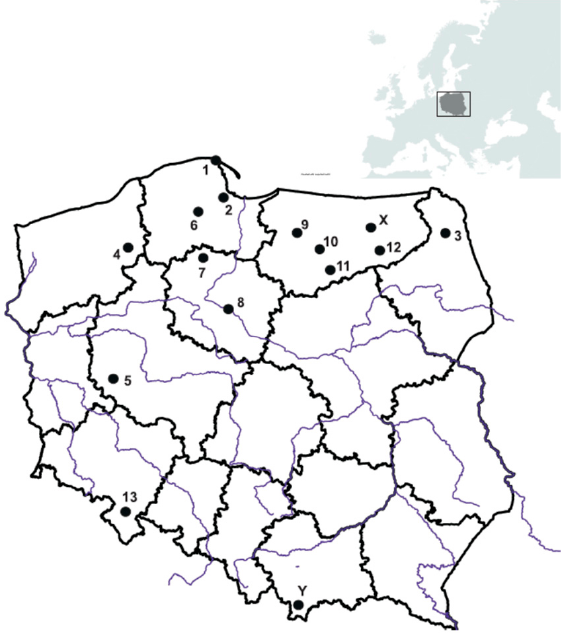
Figure 1. Sampling sites of B. edulis (1. Coastal Landscape Park; 2. Tricity Landscape Park, Osowa; X. Mazury, Gi ż ycko; 3. Augustów Primeval Forest; 4. Pomerania, Szczecinek; 5. Greater Poland, Pora ż yn; 6. Wdzydze Landscape par, Ko ś cierzyna; 7. Tuchola Pinewoods, Osiek; 8. Kujawy region, Toru ń forests; 9. Warmia, Mor ą g; 10. Warmia, Olsztyn; 11. Warmia, Pucha ł owo; 12. Mazury, Piska Forest; 13. Sudety Mts., K ł odzka Dale; X. Mazury, Gi ż ycko; Y. Tatra Mountains, Chocho ł owska Valley.